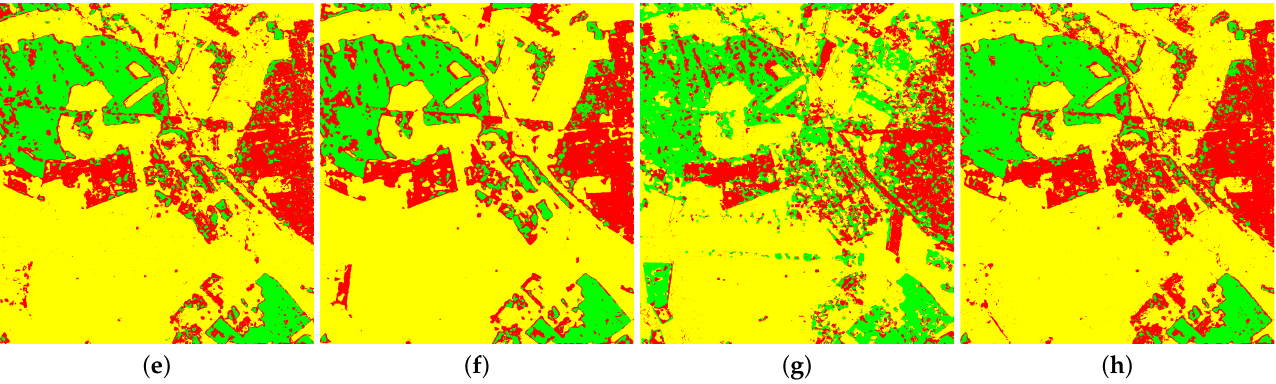
Figure 5. Prediction result of Oberpfaffenhofen image obtained by four classifiers on different forms of Touzi decomposition parameters, including ( a ) SVM on original parameters, ( b ) SVM on normalized parameters, ( c ) ANN on original parameters, ( d ) ANN on normalized parameters, ( e ) AE on original parameters, ( f ) AE on normalized parameters, ( g ) AEFT on original parameters, and ( h ) AEFT on normalized parameters.